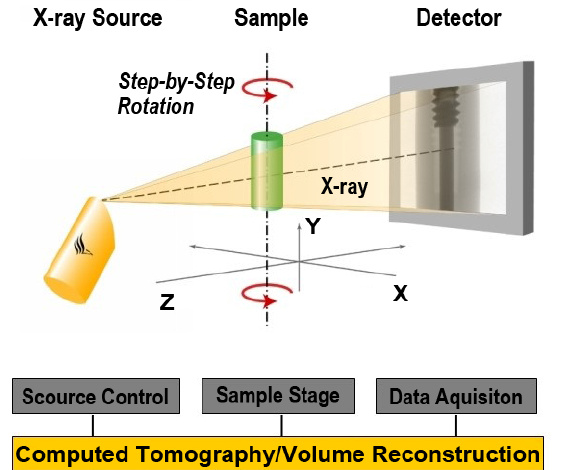
Figure 2. Phase permeability curves of different cores.